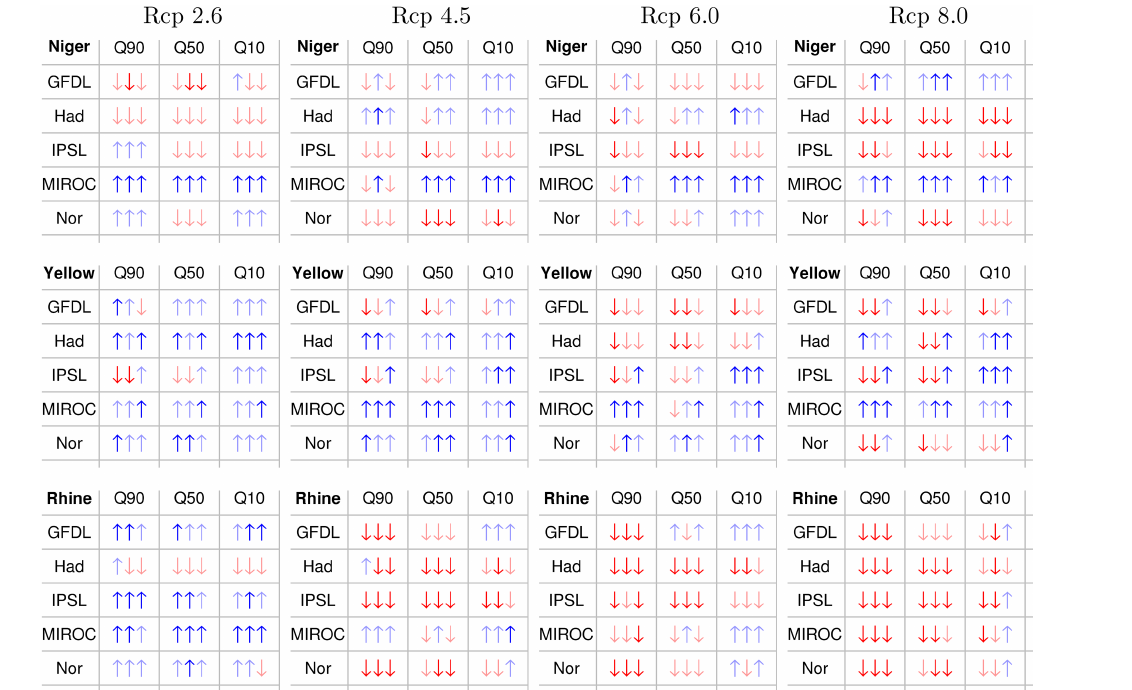
Figure 9. Direction of trends in Q 90 , Q 50 and Q 10 for the Upper Niger, Upper Yellow and Rhine grouped by basins (three horizontal bands), four RCPs (four vertical bands), driving climate models (horizontal lines), and three hydrological models. The first arrow in the small boxes corresponds to HBV, the second one to SWIM, and the third one to VIC. The arrows with statistically significant trends are thicker, and their direction up or down shows an increase or decrease,